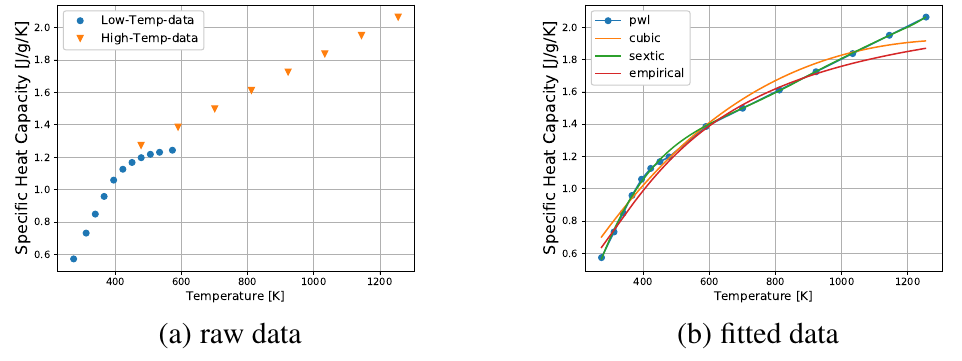
Figure 3: Specific heat capacity of the TREAT